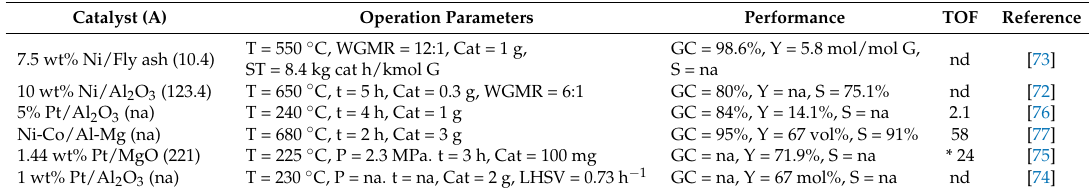
Table 6. Performance of some catalysts in the conversion of glycerol to hydrogen as reported in some literature. Catalyst (A) Operation Parameters Performance TOF Reference 7.5 wt% Ni/Fly ash